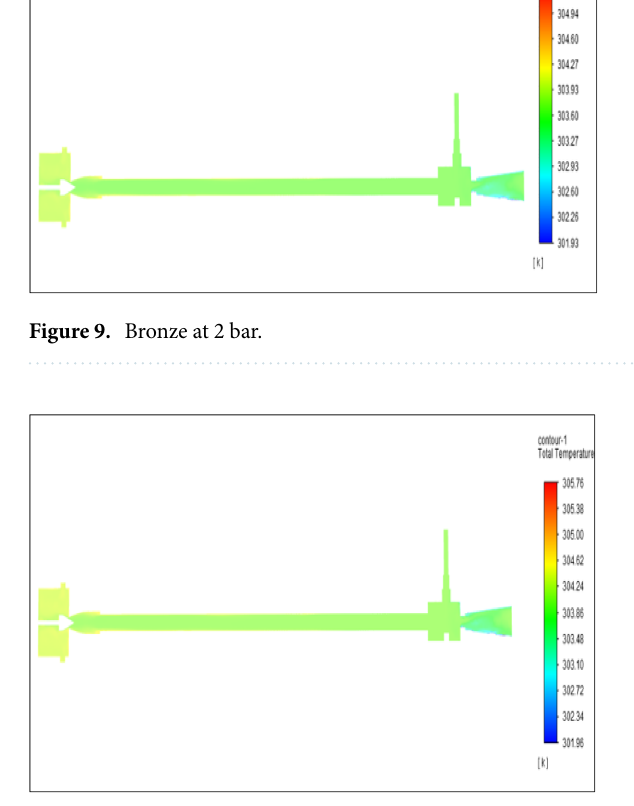
Figure 10. Copper at 2 bar.